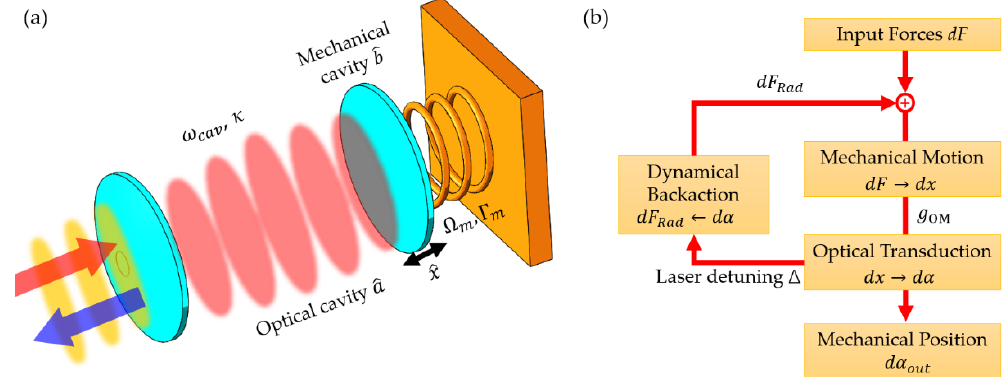
Figure 13. ( a ) Canonical schematic of a cavity optomechanical system with a laser-driven optical cavity and a vibrating mechanical cavity; ( b ) schematic of optomechanical backaction loop